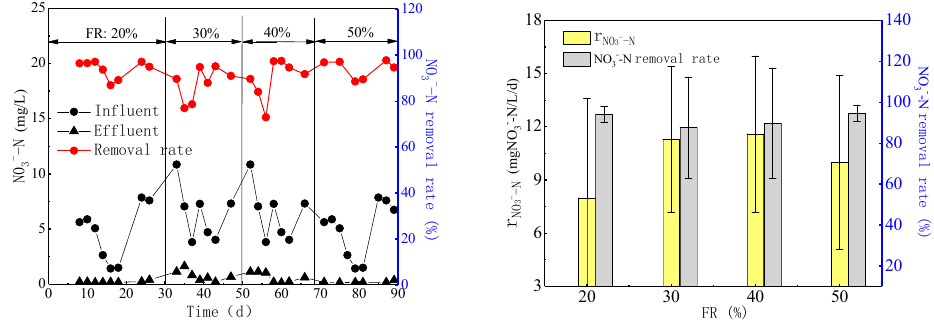
Figure 2. NO 3 − -N removal rate and denitrification rate (r NO3–N ) at di ff erent Figure 2. NO 3- -N removal rate and denitrification rate (r NO3--N ) at different FRs.